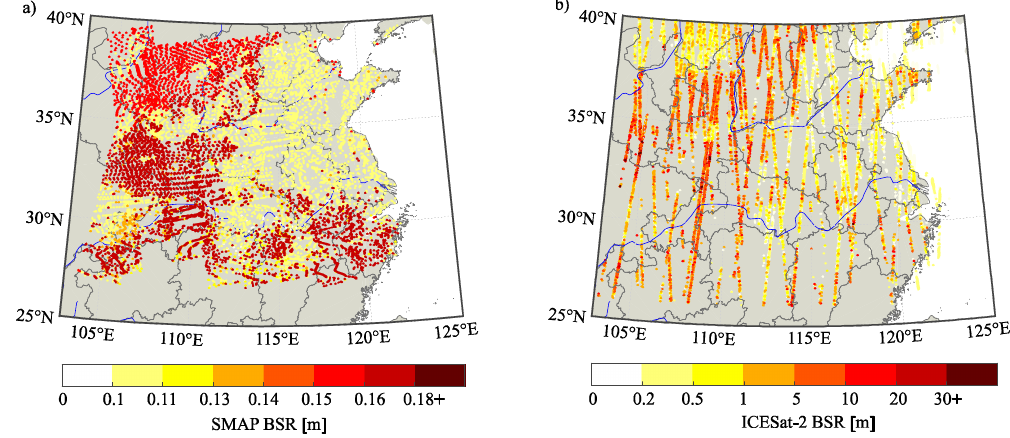
Figure 2. In ( a ), SMAP BSR estimates for the period 1–13 of April 2019 plotted at 500-sample intervals. In ( b ), ICESat-2 BSR estimates for the whole month of April 2019 plotted at 100-sample intervals.